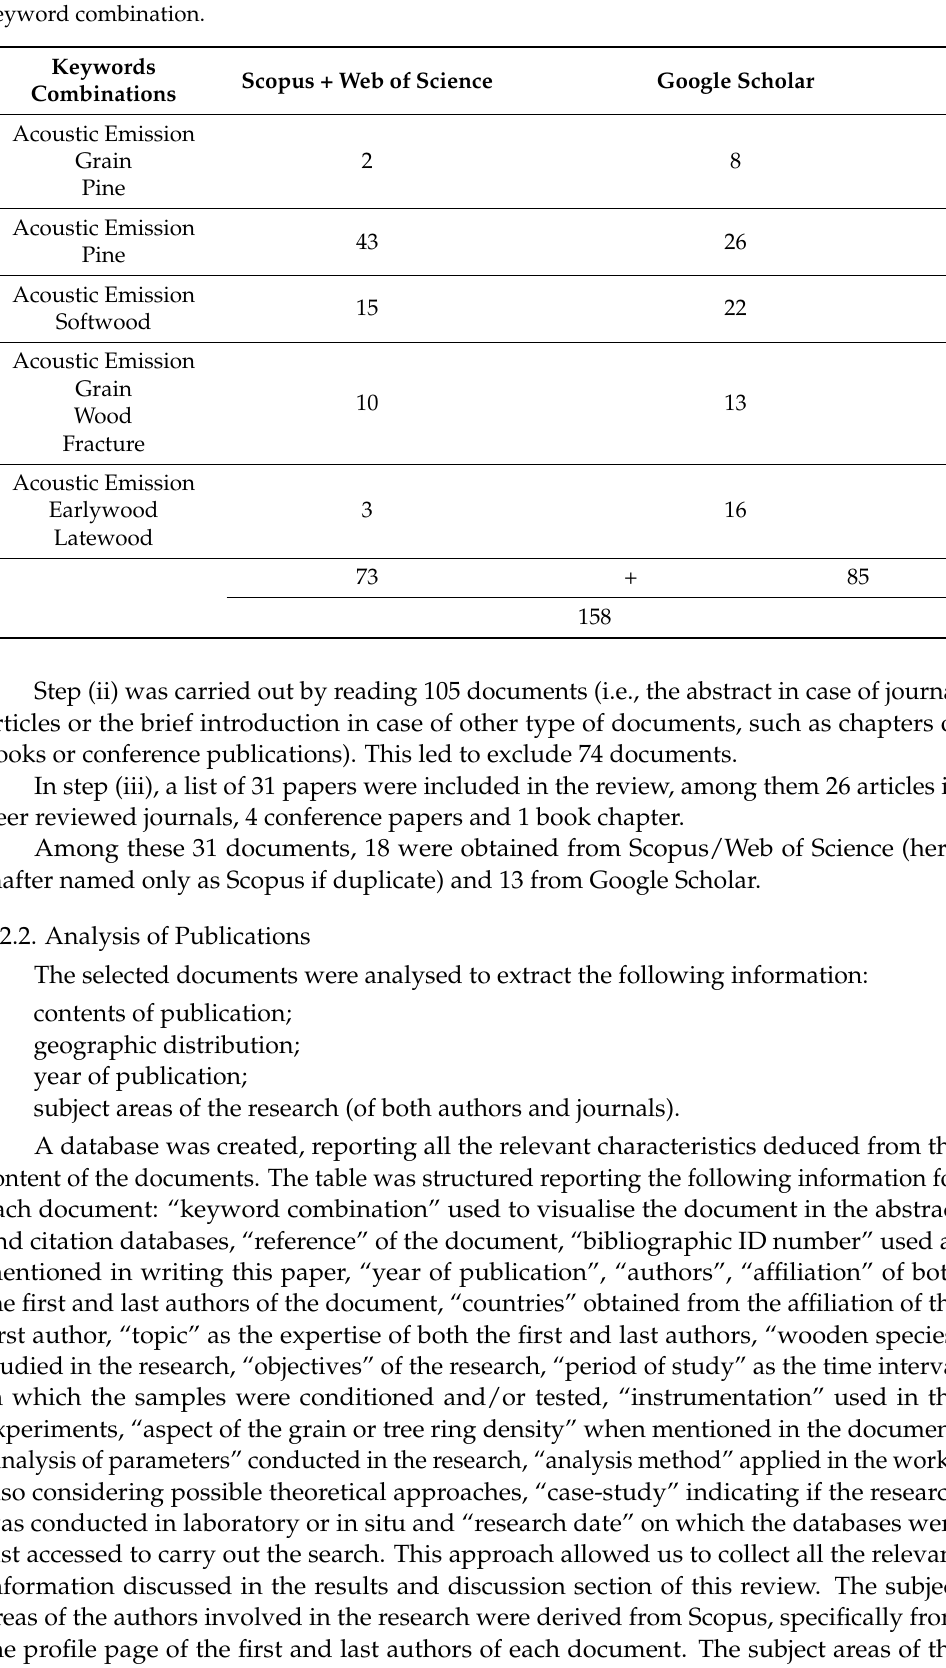
Table 1. Number of initial results obtained from Scopus, Web of Science and Google Scholar for